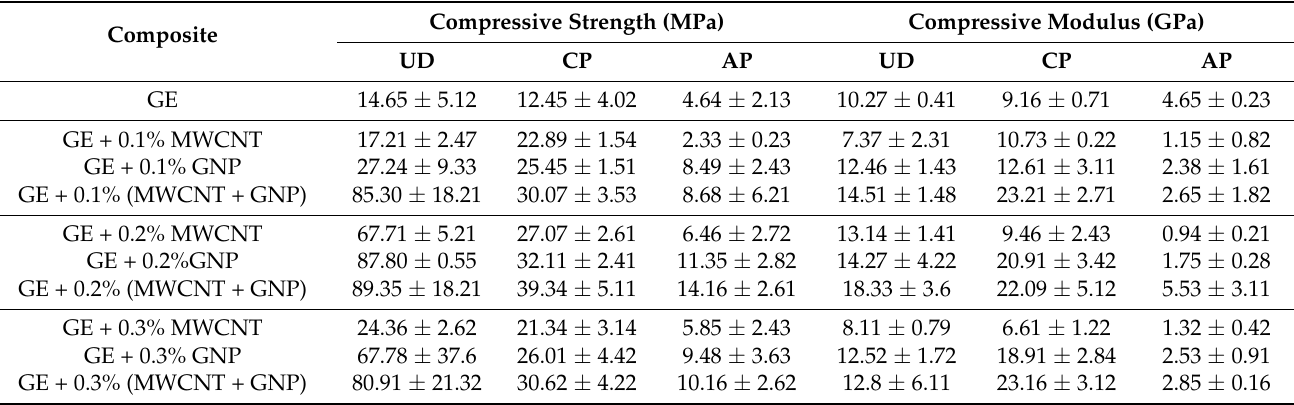
Table 3. Compressive properties of UD, CP, and AP